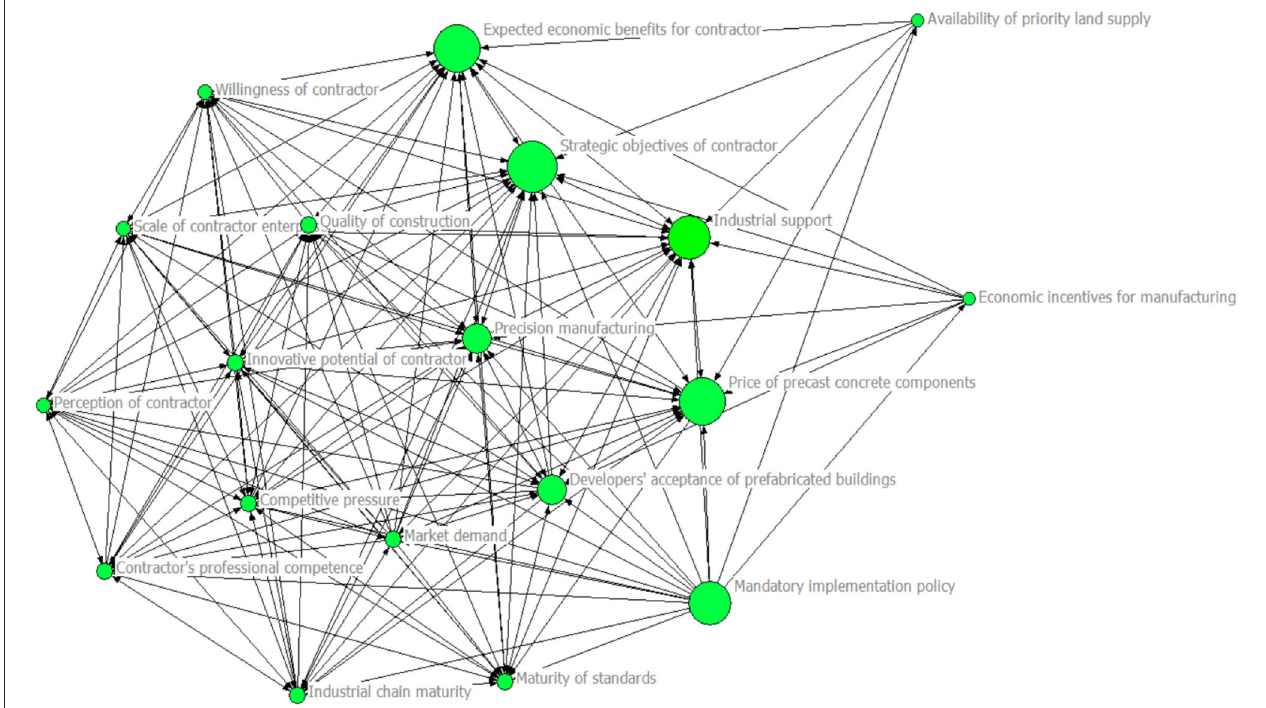
FIGURE 3 | Visual model of betweenness centrality results for influencing factors.